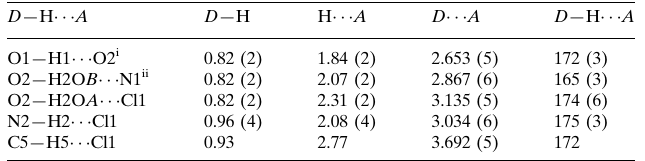
Hydrogen-bond geometry (A˚ , (cid:4)